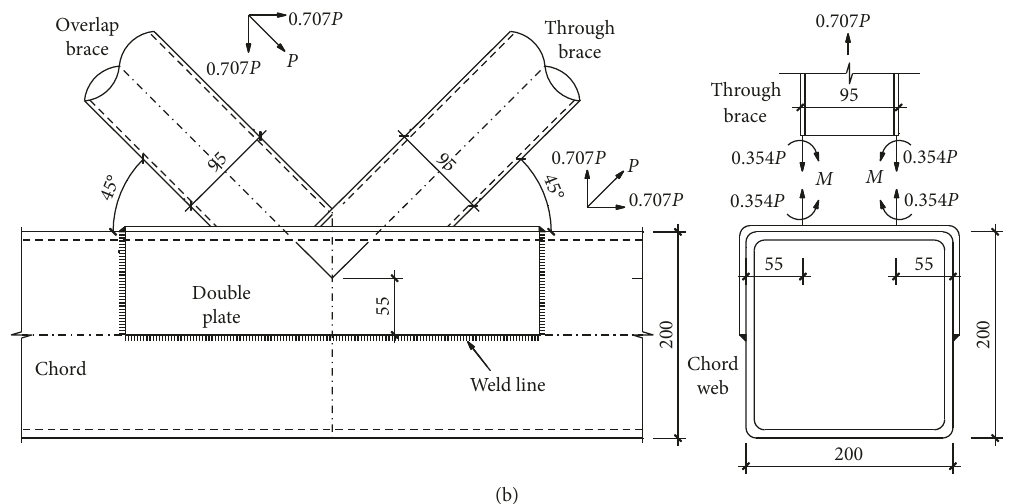
Figure 10: The load transfer mechanism of the through brace under tension. (a) K-RC and (b) K-RC1.